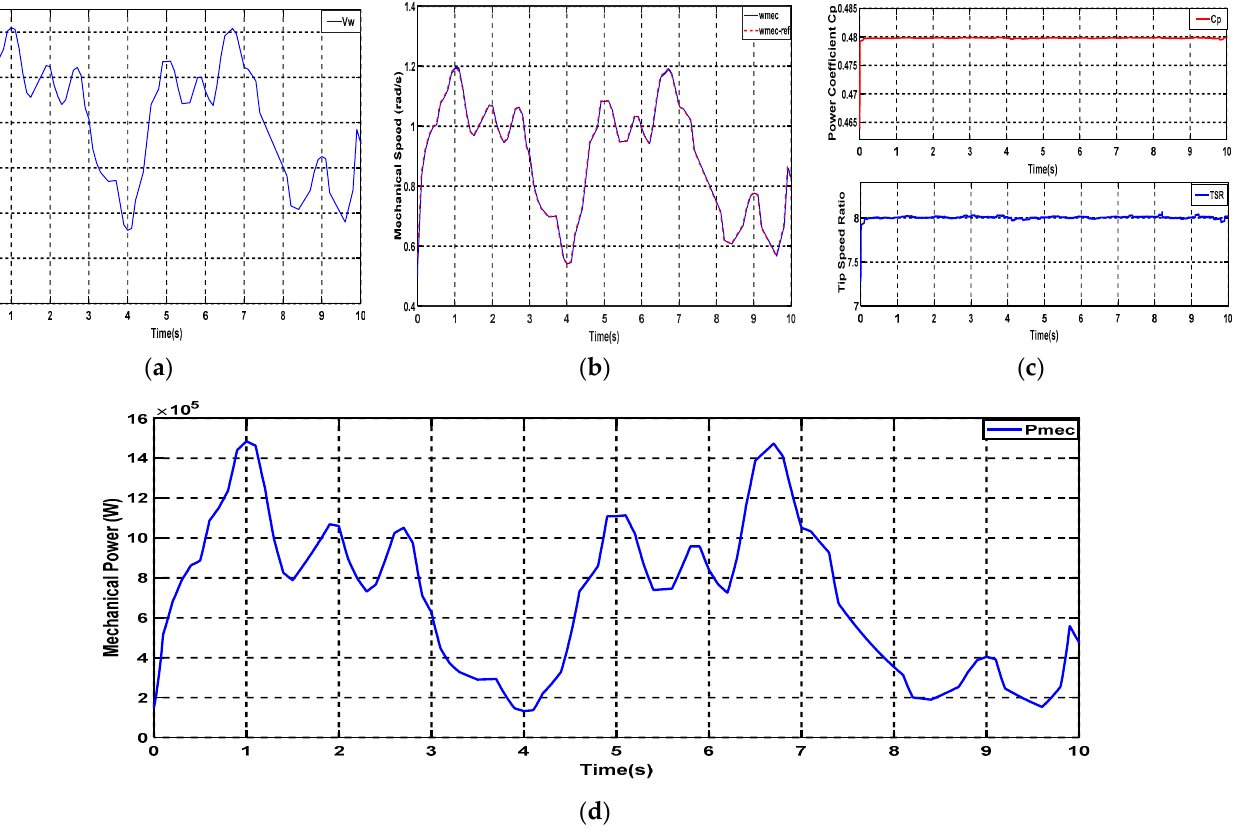
Figure 17. MPPT’s performance: wind speed (m/s) ( a ), power coefficient Cp ( λ , β ) and tip speed ra- tio TSR ( b ), Mechanical Speed of the PMSG ( c ), Mechanical Power ( d ). TSR ( b ), Mechanical Speed of the PMSG ( c ), Mechanical Power ( d